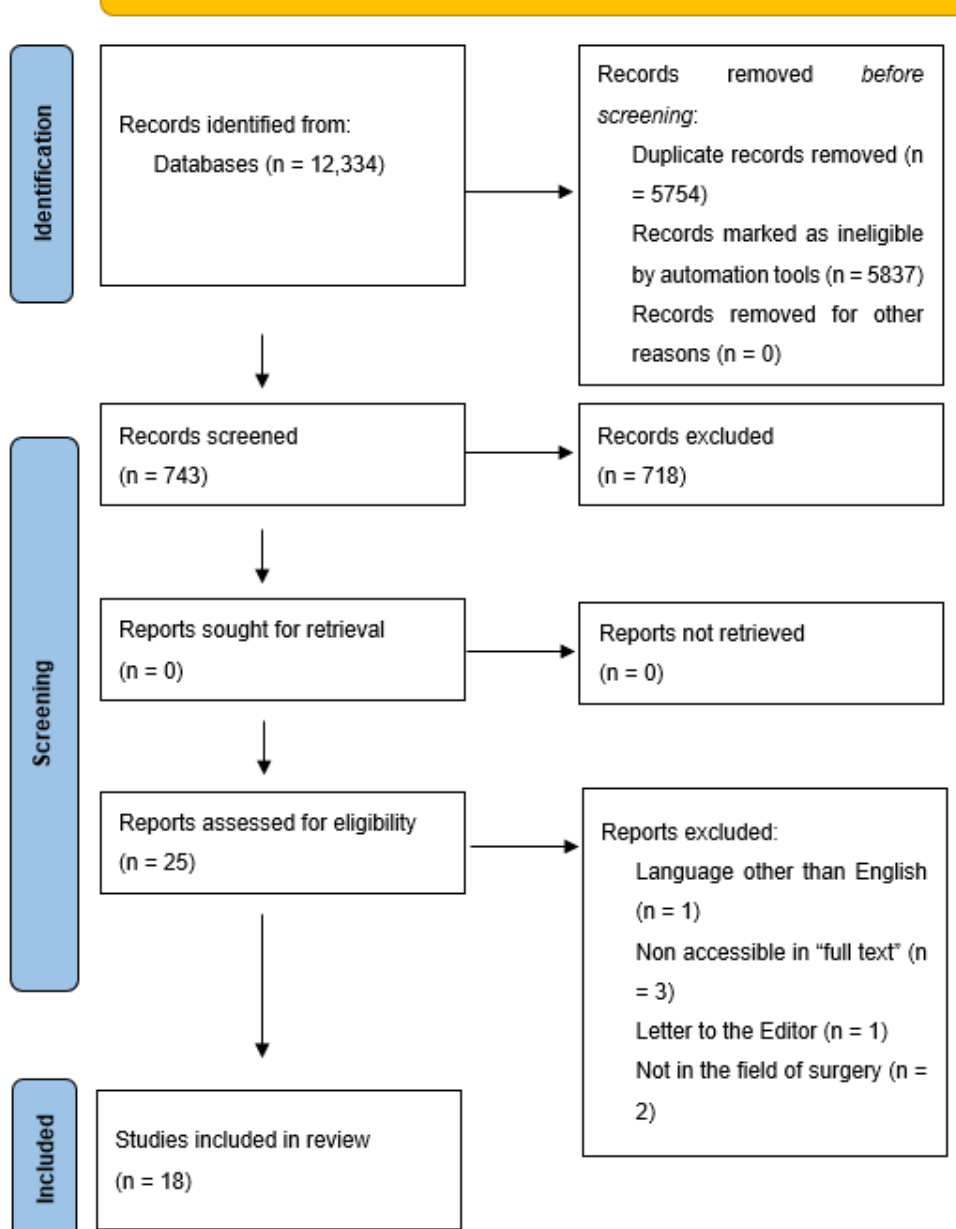
Figure 1. PRISMA 2020 flow-diagram for new systematic reviews which included searches of data- bases.